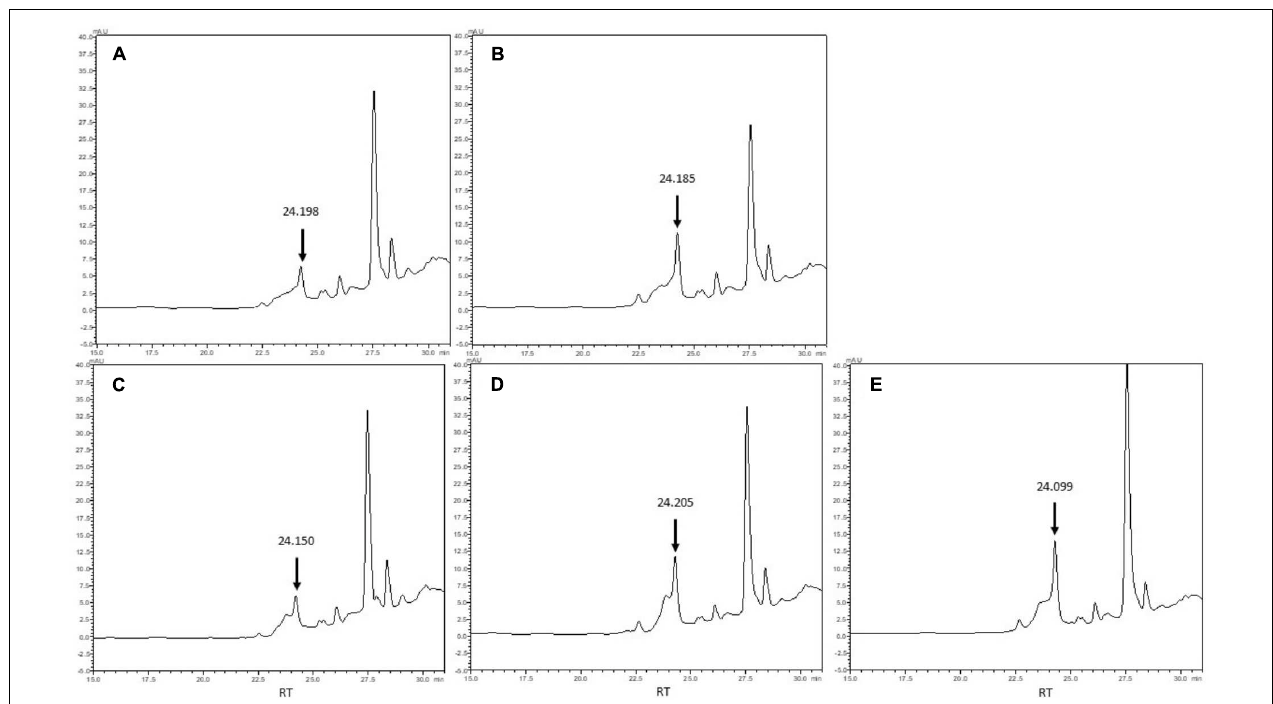
FIGURE 4 | RP-HPLC chromatogram of the cell extract (CE) from L. reuteri CRL 1098 ( A CoCl 2 B DMB + CoCl 2 ) and L. coryniformis CRL 1001 ( C - CoCl 2 D - DMB + CoCl 2 E - L -Thr + CoCl 2 ). An arrow indicates peaks corresponding to the corrinoid compound.